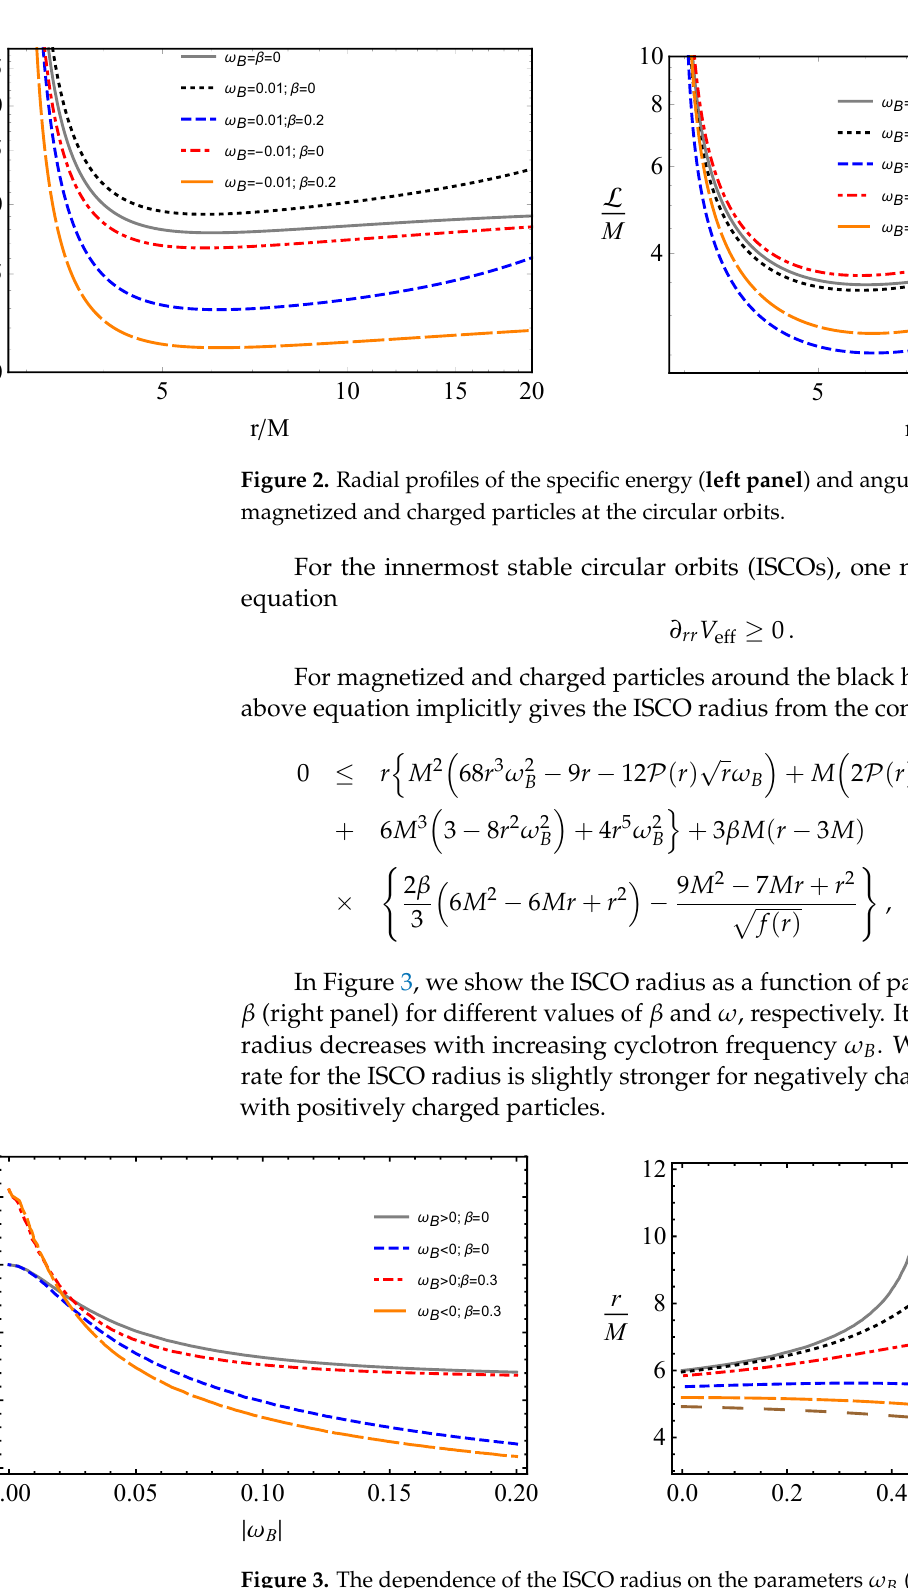
Figure 3. The dependence of the ISCO radius on the parameters ω B ( left panel ) and β ( right panel ). Moreover, it is seen from the figure that there is an upper value of the parameter β of the particles with positive electric charge ω B , while the upper value for electrically neutral magnetized particles is β = 2/3, and in that value of β the ISCO lies at infinity. This means that the particles with β = 2/3 cannot be in stable orbits around magnetized black